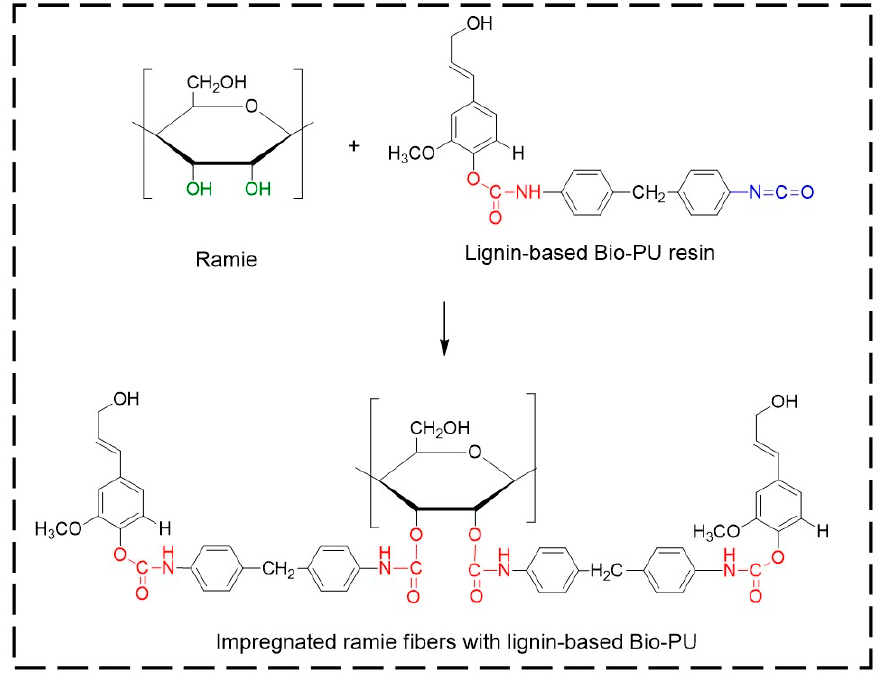
Figure 13. The possible scheme reaction of ramie fibers with lignin ‐ based Bio ‐ PU resin. DSC analysis detected two thermal events on ramie fiber before and after impregna ‐ tion, namely an endothermic reaction and an exothermic reaction (Figure 14). The endo ‐ thermic reaction is a heat absorption reaction by the ramie fiber, while the exothermic reaction is a heat release reaction by the ramie fiber [73]. The peak of the endothermic reaction ( Tp 1 ) in the original ramie fiber occurred at a temperature of 46 °C, which is the process of evaporation of water. In general, impregnation resulted in a slightly higher Tp 1 value. Ramie fiber impregnated with L ‐ Isolated and L ‐ Ac had a lower Tp 1 value than that of ramie impregnated with L ‐ MeOH. The difference in Tp 1 value between natural ramie and impregnated ramie is influenced by differences in fiber moisture content. The mois ‐ ture content of natural ramie is 5.15%, and the moisture content of impregnated ramie is between 6 and 10%. No significant influence of increasing the impregnation time on the Tp 1 value of ramie impregnated with lignin ‐ based Bio ‐ PU resin was observed.